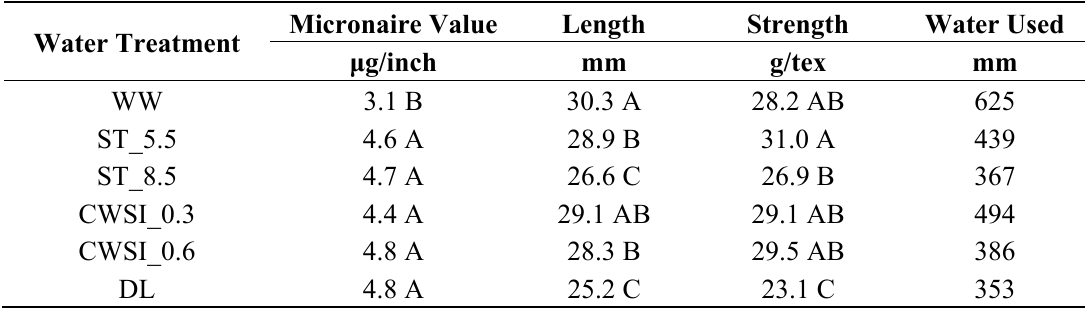
Table 1. Lint quality characteristics and seasonal crop water use for six different water treatments. Means within the same column followed by the same letter are not significantly different at p ≤ 0.05.